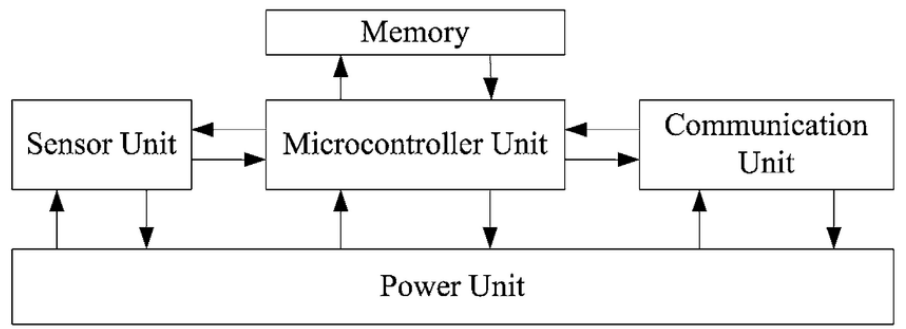
Figure 2. Sensor